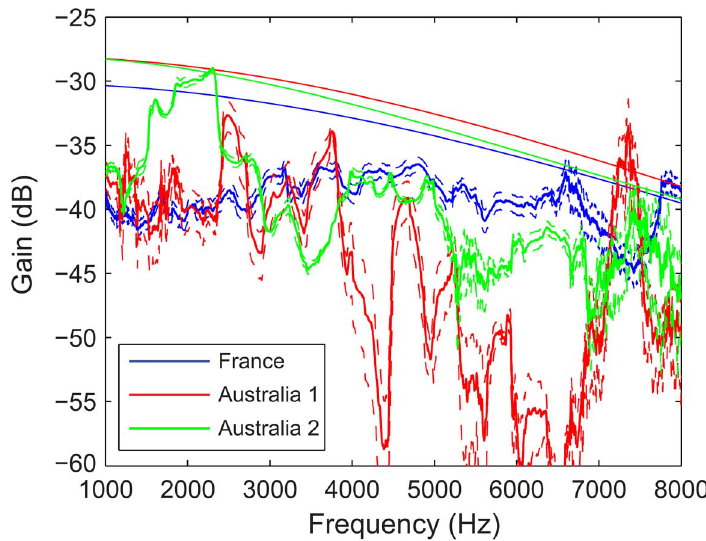
Figure 5. Comparison of transfer functions in France and in Australia. The transfer functions were calculated between the recordings obtained at 2 m and those recorded at 50 m in Australia and between 2 m and 64 m for the recordings made in France. The solid line represents the mean, and dashed lines represent plus or minus 2 standard errors for each transfer function. The smooth thin lines represent the theoretical attenuation due to spherical spreading and atmospheric attenuation. The Australia site 1 was an open area close to the nesting sites and the recordings were performed during the day with low wind. The attenuation curve was obtained using T=30 u C, 15% relative humidity and 1 atm. The Australia site 2 is next to zebra finch nesting sites and includes sparse vegetation and the recordings were performed on a windless evening. The attenuation curve was obtained using T=25 u C, 15% relative humidity and 1 atm. The recordings in France are in an open field and were obtained during the day in low wind conditions. The attenuation curve was obtained using T=11 u C, 50% relative humidity and 1 atm.